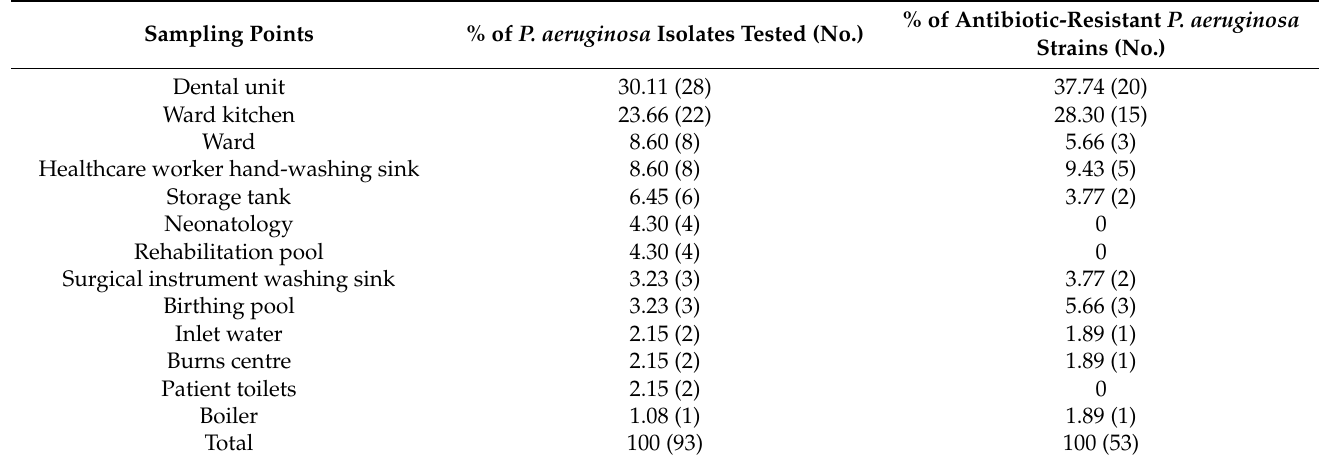
Table 1. P. aeruginosa isolates in the various water sampling points.